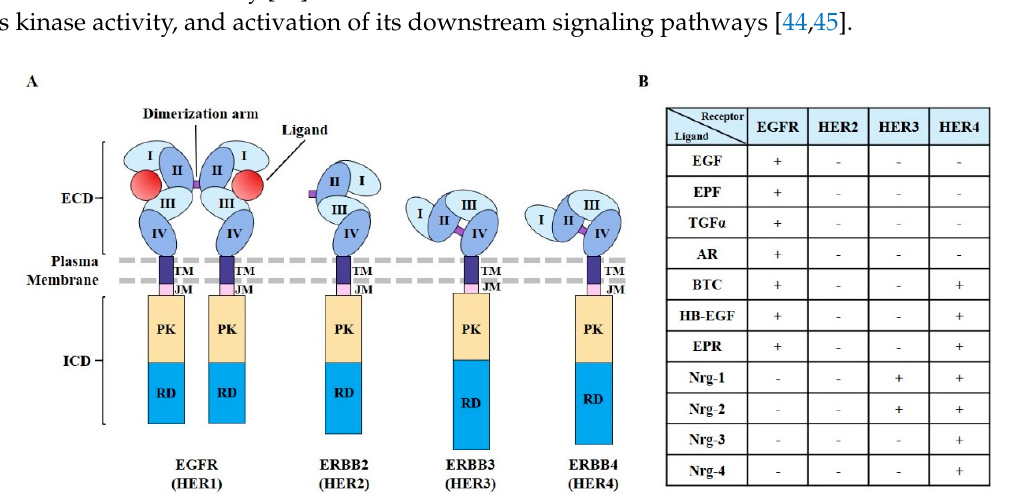
Figure 1. Structure of the human ErbB/HER receptors. ( A ) Extracellular domain (ECD) of each receptor consists of four domains (I–IV). Domains I and III participate in ligand binding (except for those of HER2). Domain II participates in dimer formation. Intracellular domain (ICD) is composed of protein kinase domain (PKD) and regulatory domain (RD). HER3 does not have active kinase domain. ( B ) Growth factors that can bind to the ErbB/HER receptors are indicated. AR, amphiregulin; BTC, betacellulin; EGF, epidermal growth factor; EPF, extracellular protein factor; EPR, epiregulin; HB-EGF, heparin-binding epidermal growth factor-like growth factor; Nrg-1/2/3/4, neuregulin-1/2/3/4; TGF- α , transforming growth factor α . TM denotes transmembrane and JM denotes juxtamembrane segments.